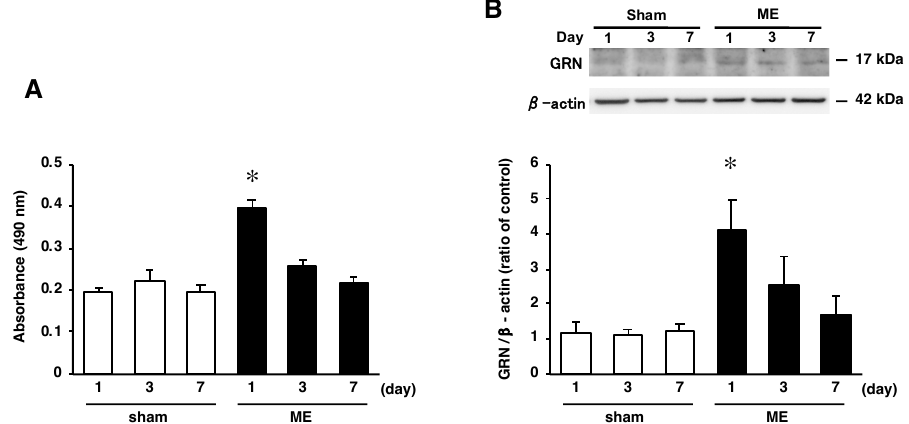
Figure 3. ( A ) Time course of changes in the tissue elastase activity in the sham-operated (sham; white bars) and ME-operated groups (ME; black bars) on days 1, 3, and 7 after surgery. The results are expressed as the mean ± SD ( n = 6 each). * Significant difference from the sham-operated group ( p < 0.05); ( B ) Time course of changes in the levels of granulin (GRN) protein in the sham-operated (sham; white bars) and ME-operated groups (ME; black bars) on days 1, 3, and 7 after ME. Bands corresponding to GRN were scanned, and the scanned bands were normalized by β-actin on the same blot. Results are expressed as the mean ratio of the non-operated (control) group ± SD ( n = 8 each). * Significant difference from the sham-operated group ( p < 0.05).